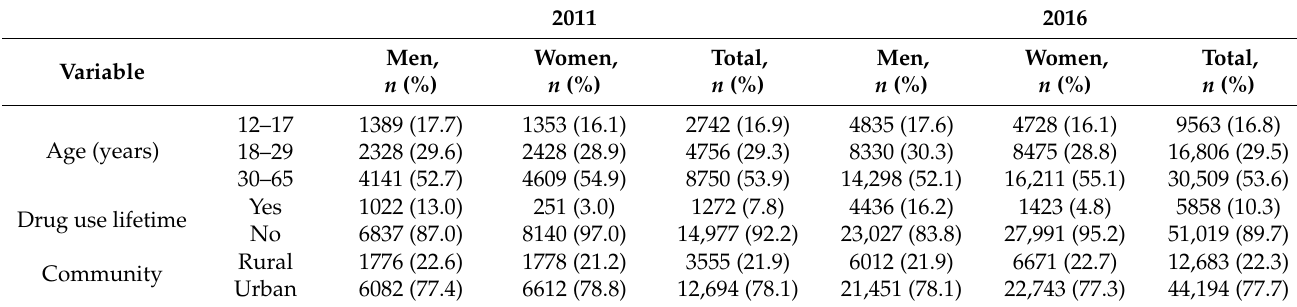
Table 1. Sociodemographic structure of the two household